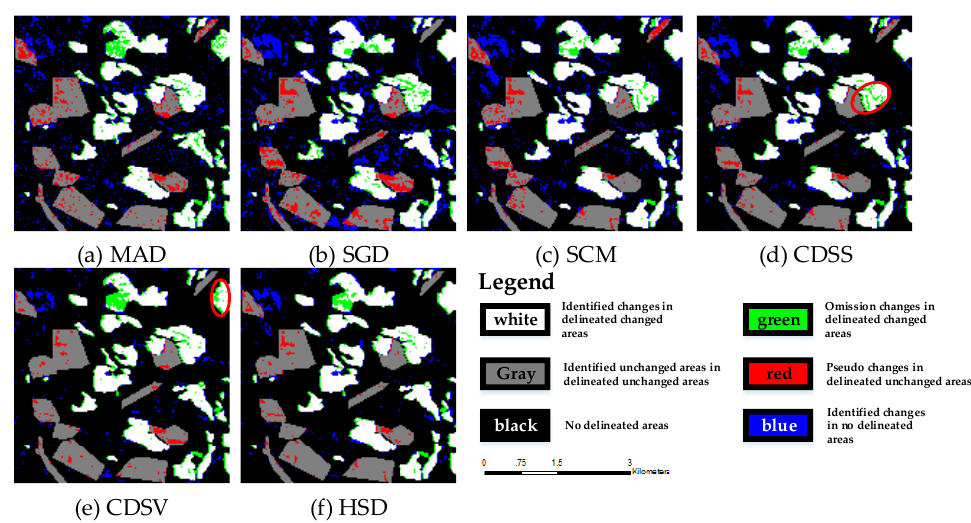
Figure 7. Change maps produced by different algorithms of patch 1.